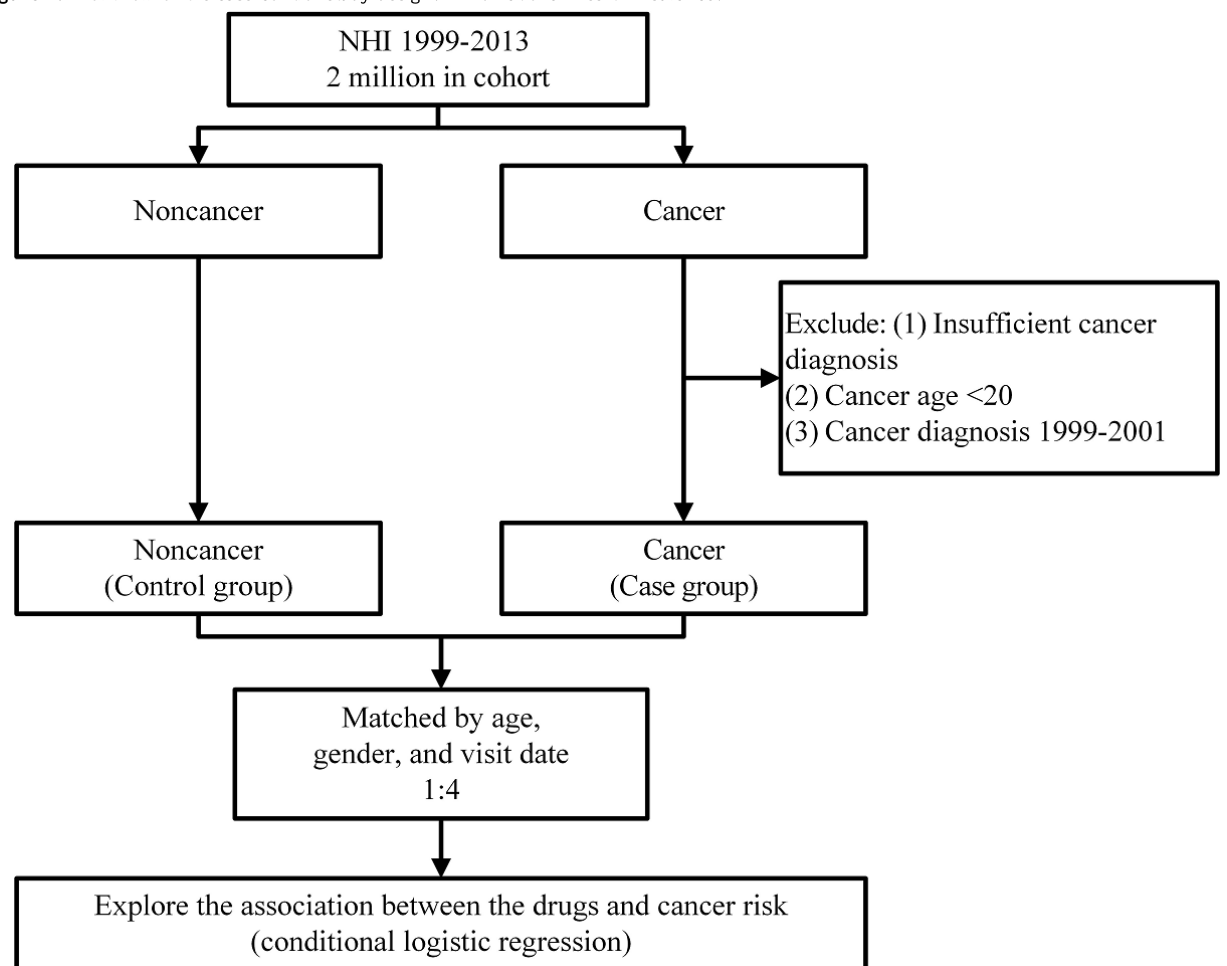
Figure 1. Workflow of the case-control study design. NHI: National Health